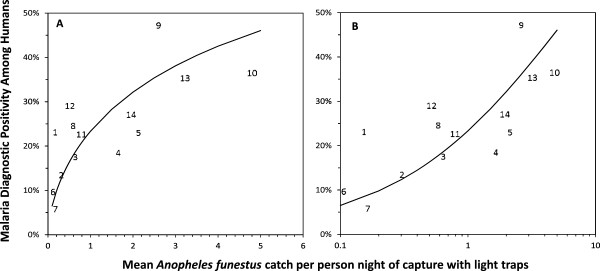
Relationship between malaria diagnostic positivity among human residents and mean catches of Anopheles funestus per trap night of capture with light traps in each cluster, plotted with a standard (A) and logarithmic (B) horizontal axis. Each data point represents the mean diagnostic positivity across all ages for a single cluster, numbered as described in Figure 2. The plotted lines represent the generalized linear mixed model fitted to these data, as described in the entomological and epidemiological data analysis section. Odds ratio [95% Confidence interval] for a ten-fold increase in the mean Anopheles funestus catch = 4.378 [2.438, 7.8580]; P < 0.001.